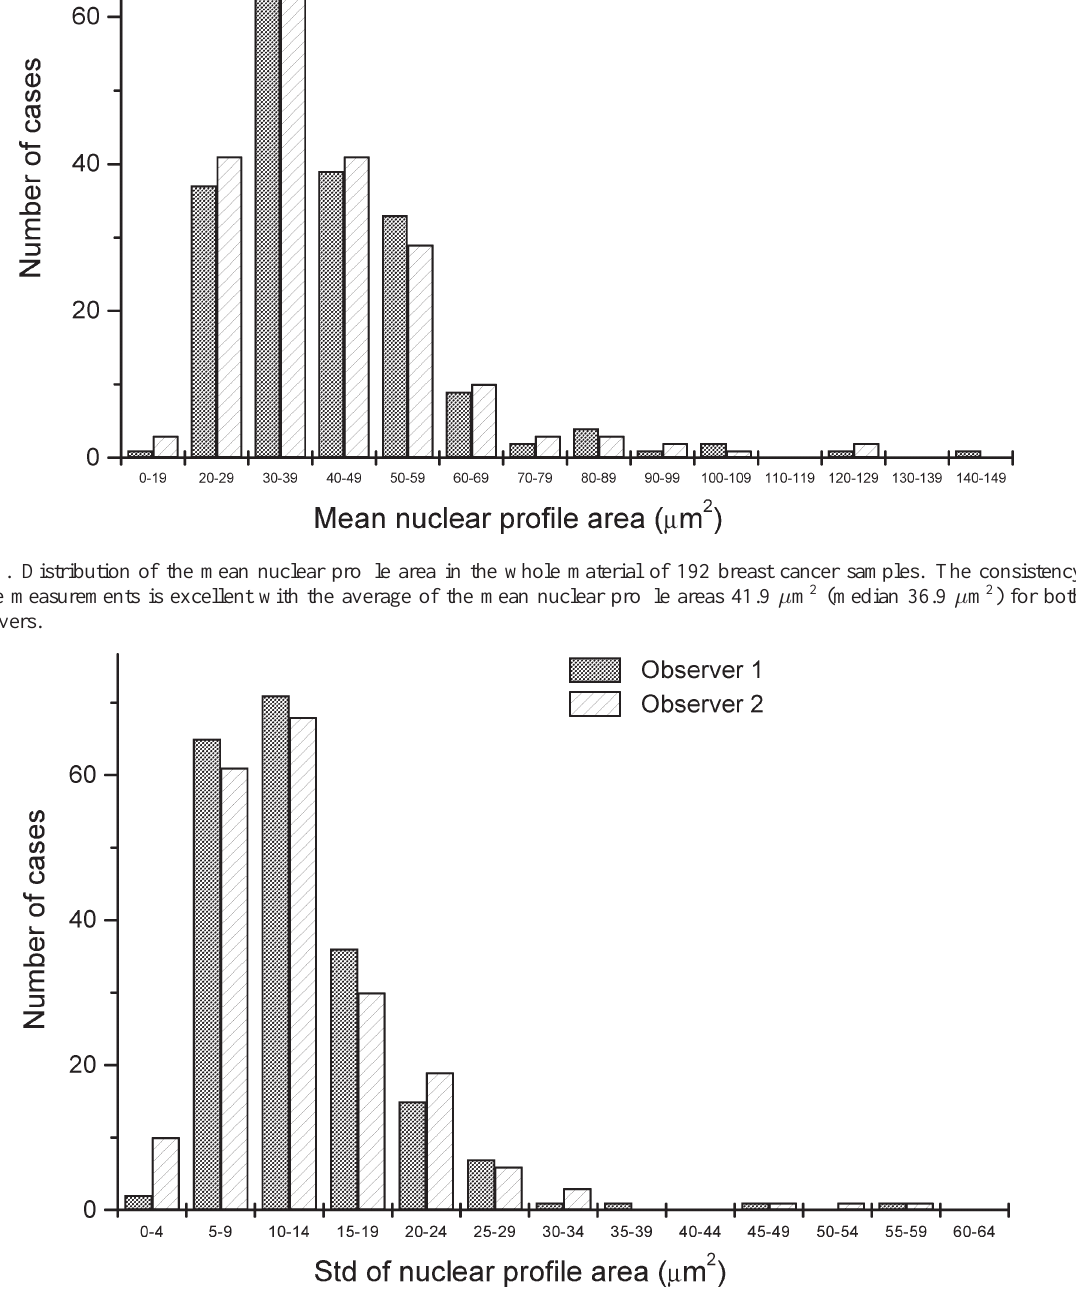
Fig. 2. Distribution of the standard deviation (SD) of nuclear profile area in the material of 192 samples of invasive breast cancer. Also the average SD was the same (12.9 µ m 2 , median 11.5 µ m 2 ) for both